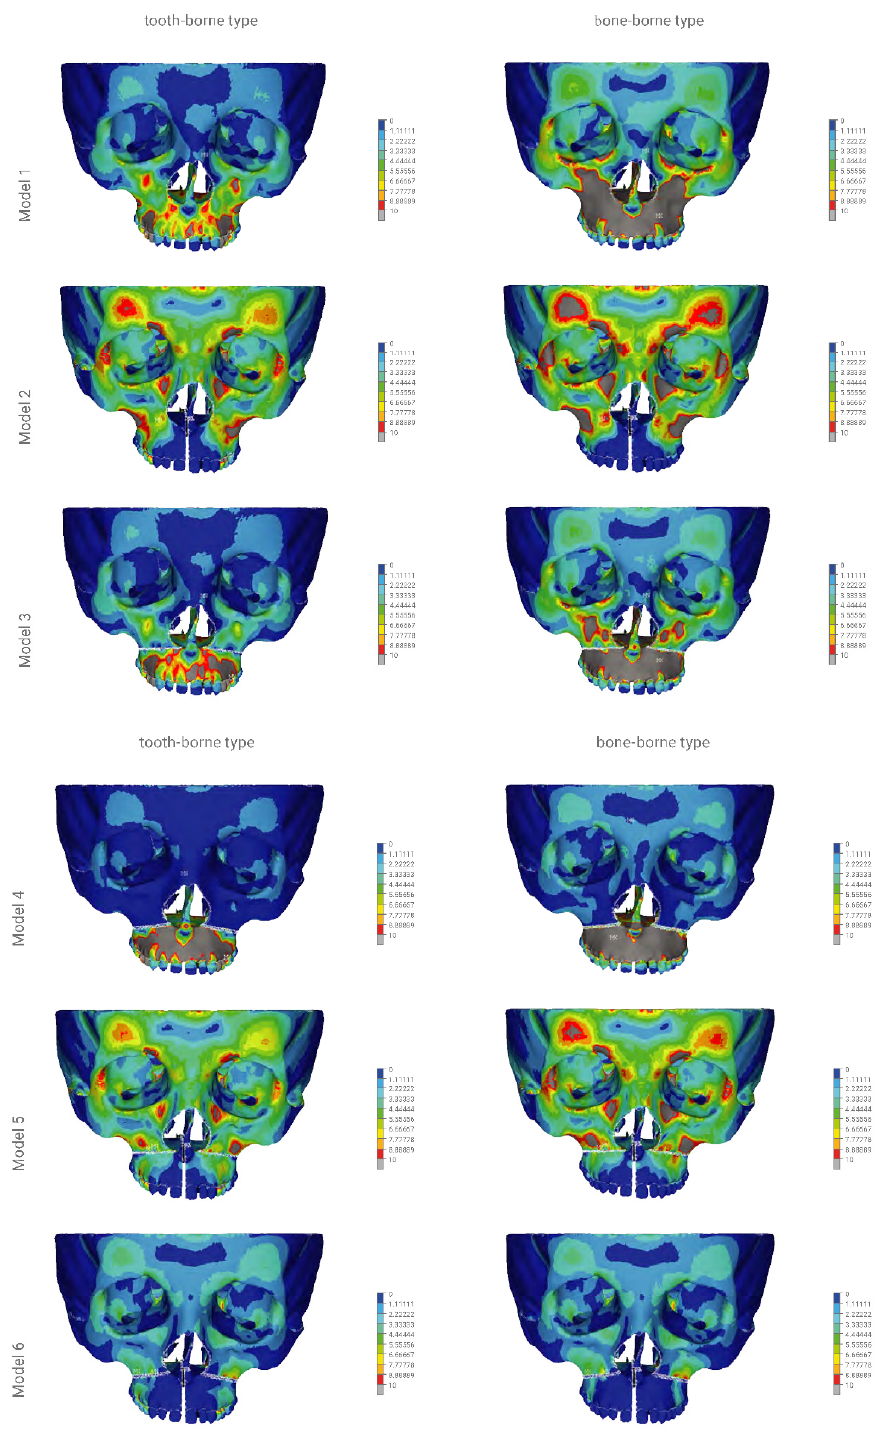
Figure 5. The finite element model showing the front view of the distribution of the stresses (scale 0–10 MPa) according to Huber throughout the craniofacial skeleton as a result of palatal expansion using five different surgical procedures, and without an osteotomy. Model 1—without an osteotomy; model 2—sagittal osteotomy; model 3—transversal osteotomy modo Le Fort I without a PMJ separation; model 4—transversal osteotomy modo Le Fort I with a PMJ separation; model 5—sagittal osteotomy with a transversal osteotomy modo Le Fort I without a PMJ separation; model 6 (the model used for finite element analysis)—sagittal osteotomy with a transversal osteotomy modo Le Fort I with a PMJ